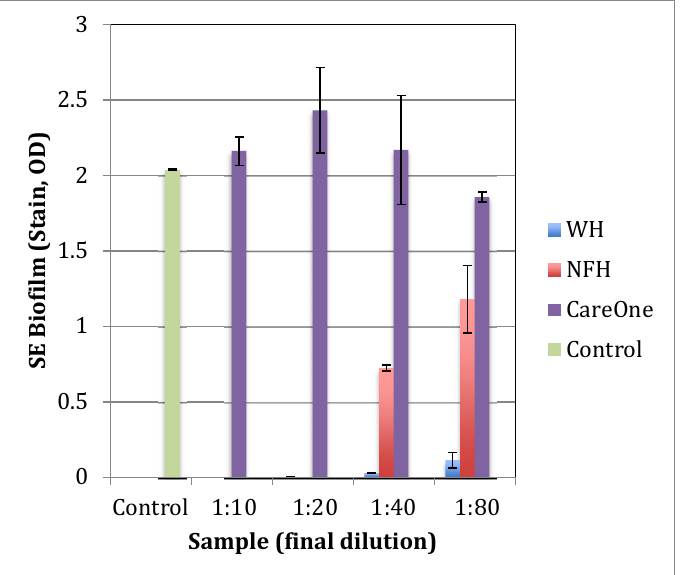
Figure 2. The effect of witch hazel extracts on biofilm formation by S. epidermidis . Bacteria were grown overnight in TSB in the presence of increasing amounts of witch hazel extracts, ethanol, or culture broth alone (control). After 24 h, unbound bacteria were removed, biofilm bacteria stained in crystal violet, stain dissolved in SDS and OD 630 were determined. Witch hazel extracts tested: WH (whISOBAX, StaphOff Biotech), CareOne extract (CareOne), and NFH (Nutritional Fundamentals for